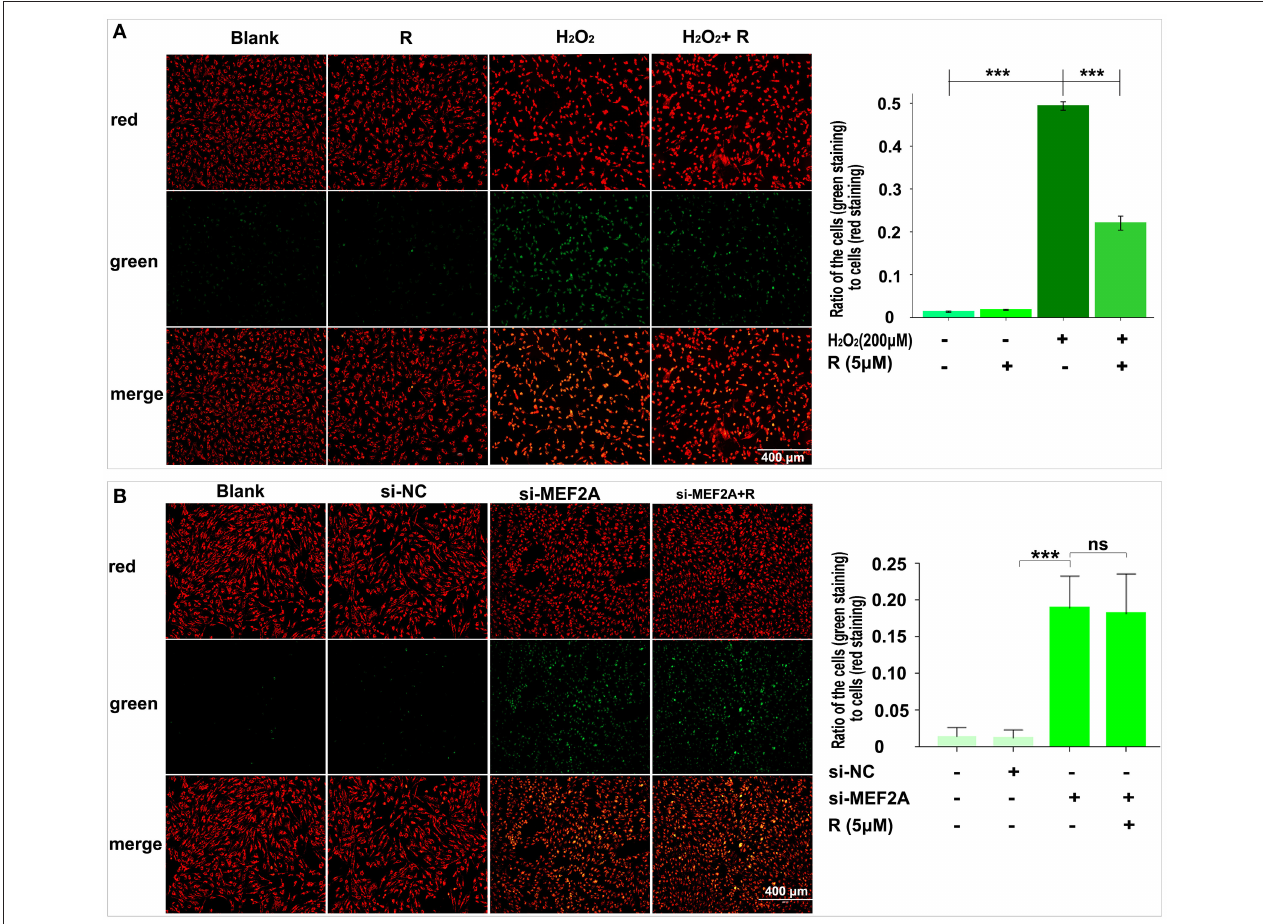
FIGURE 4 | The impact of resveratrol on the decrease of mitochondrial membrane potential caused by treatment with H 2 O 2 or by silencing MEF2A with siRNA. (A) Using JC-1 staining to test the impact of resveratrol on the cellular mitochondrial membrane potential of HUVEC treated with or without H 2 O 2 . (B) Using JC-1 staining to detect the impact of resveratrol on the cellular mitochondrial membrane potential of HUVEC caused by down-regulated MEF2A with siRNA. R, resveratrol; Si-NC, the negative control of siRNA; Si-MEF2A, MEF2A specific siRNA. All experiments were performed independently for 3 times. Mean ± SD is represented as bar plot. The statistical significance is analyzed by the unpaired Student’s two-tailed t -test. ns, no significance; *** P < 0.001 between groups